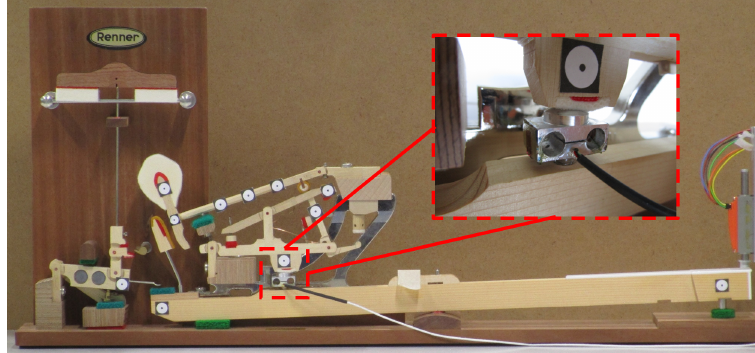
Figure 13. Experimental homemade force sensor set-up.